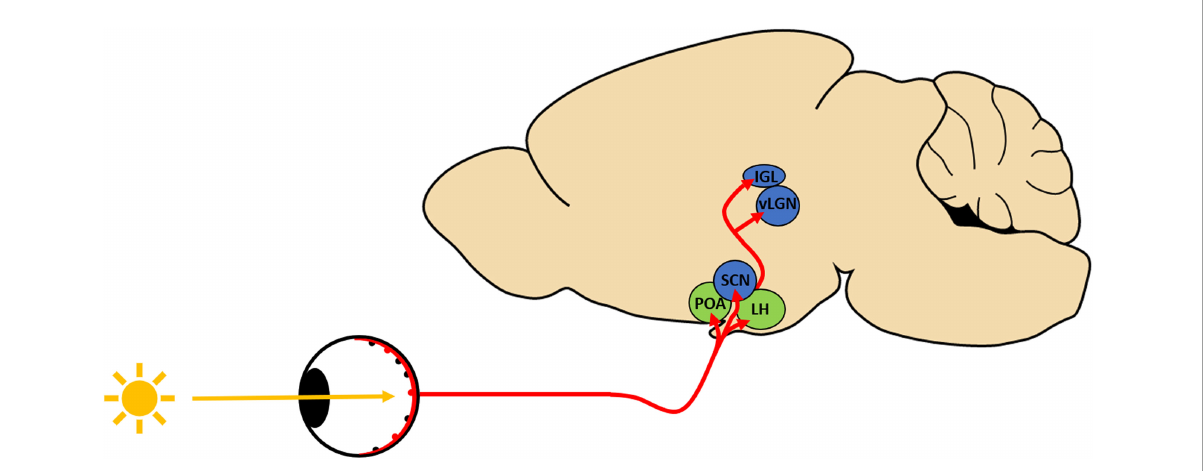
FIGURE1 Schematic depicting intrinsically photosensitive retinal ganglion cell (ipRGC) projection regions implicated in light-induced regulation of sleep/wake behavior. ipRGCs (red) send light information via the retinohypothalamic tract to sleep/circadian centers in the hypothalamus (POA, Preoptic area; SCN, suprachiasmatic nucleus; LH, lateral hypothalamus) as well as to specific thalamic targets (IGL, inner geniculate leaflet; vLGN, ventrolateral geniculate nucleus). Many of these regions express opioid receptors that could underlie the opioid-induced alterations in photoentrainment. Blue: circadian photoentrainment centers; green: regions involved in light-induced